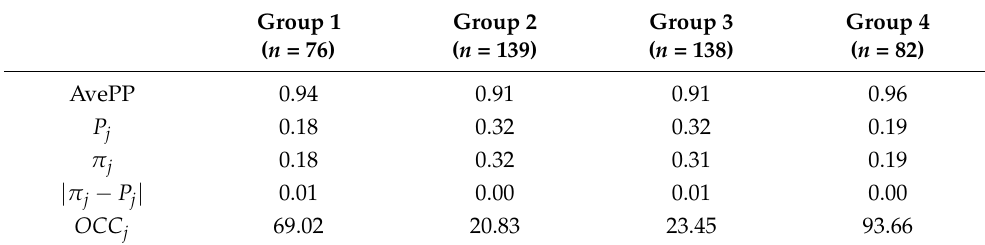
Table 4. Model adequacy